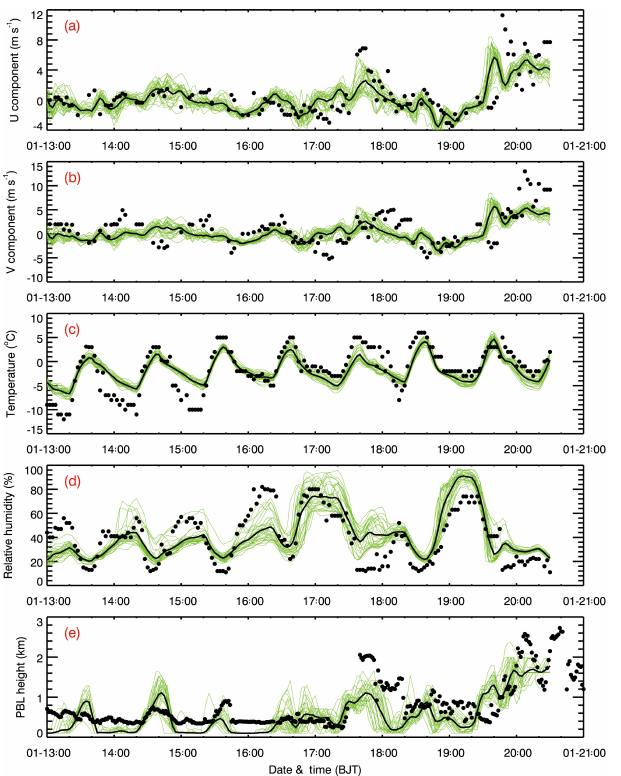
Figure 5. Temporal evolution of the (a) POA, (b) SOA, (c) sul- fate, (d) nitrate, and (e) ammonium mass concentrations at IRSDE in Beijing from each ensemble member (thin green lines), the ensemble mean (bold black line), and observations (black dots) from 13 to 20 January